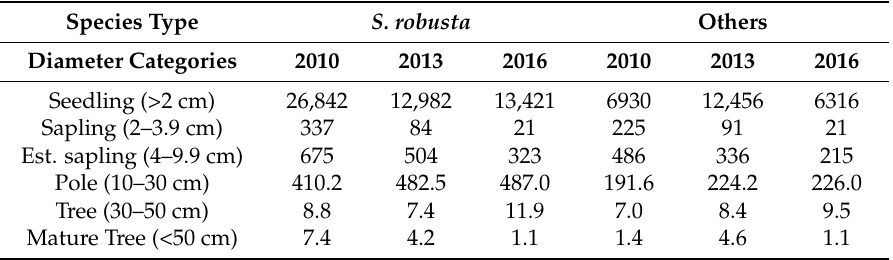
Table 5. Stand condition in the CF (n/ha) in different Inventory Period.